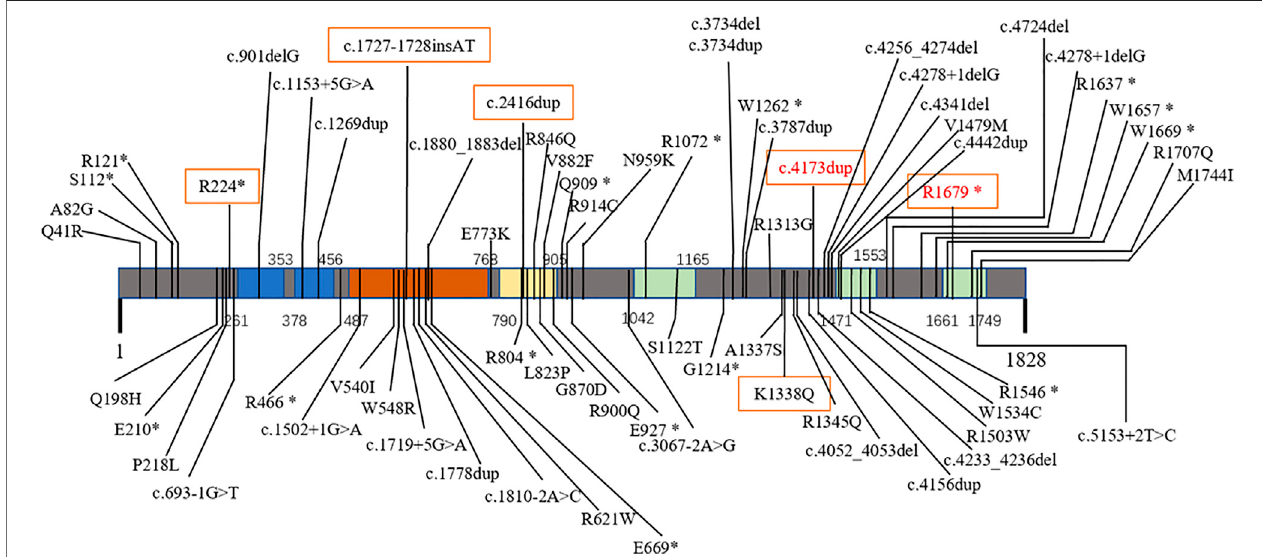
FIGURE 1 | Mutations of CHD2 -related epilepsy in different domains. Primary structure and mutations in the CHD2 protein: chromodomain 1 (261 – 353) and 2 (378 – 456) (blue); SNF2-related helicase domain (487 – 768, brown) with DEAD-like helicase superfamily (503 – 648) and helicase ATP-binding (496 – 666) domains; ATP helicase domain (790 – 905, yellow); and domains of unknown function (1042 – 1165, 1471 – 1553, 1661 – 1749, green). Red text: previously reported mutations. Boxed text , mutations in this report.